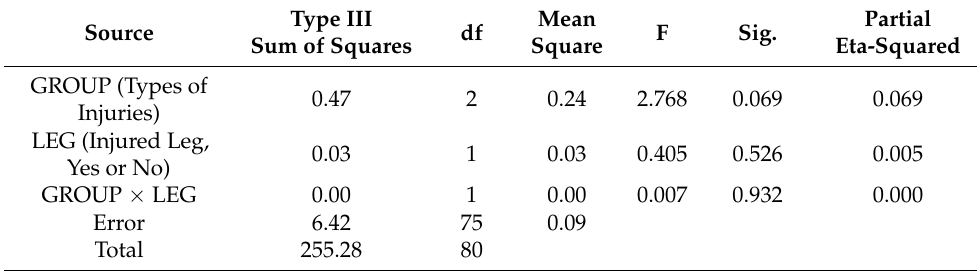
Table 2. Effect of main factors on the level of knee flexor